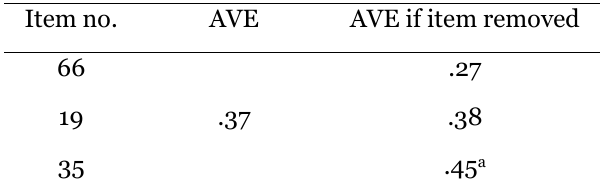
Item no. AVE AVE if item removed 66 .27 .37 19 .38 35 .45 a